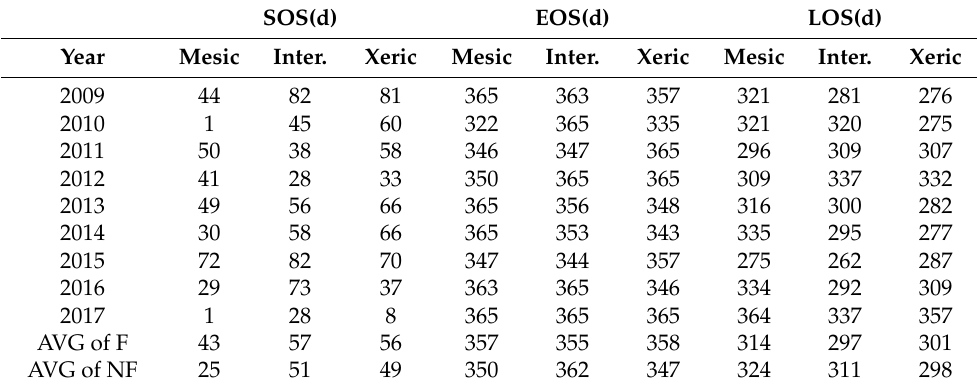
Table A1. Description of ecosystem-scale phenology of the mesic, intermediate, and xeric sites. SOS